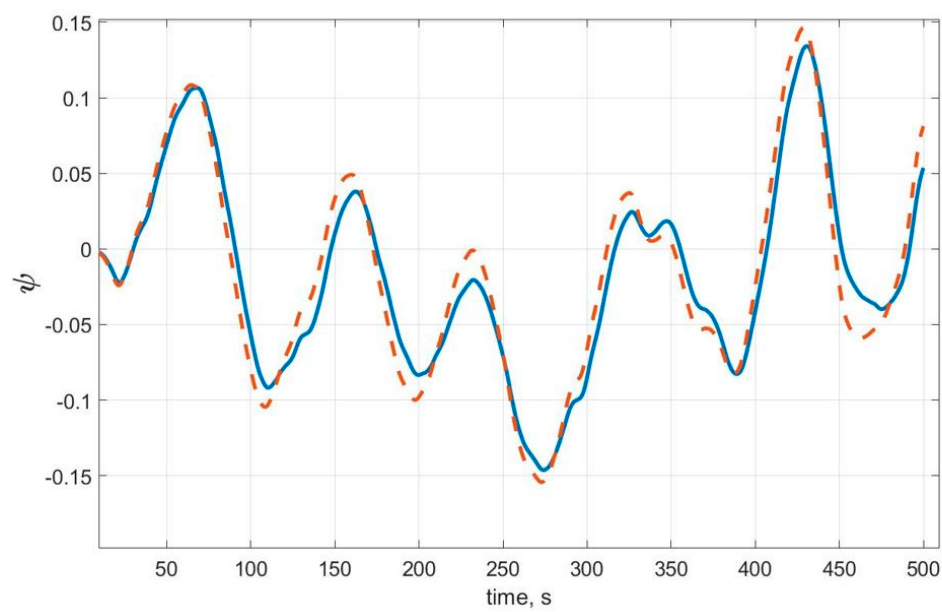
Figure 11. Transient processes of a single-cycle discrete system with a sampling periods T 1 and a multi-rate discrete UAV stabilization system.